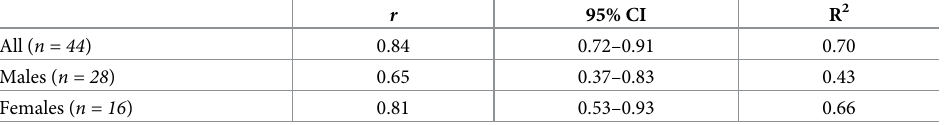
Table 2. Correlation and coefficient of determination for the association between the IsoKai Peak (kg) and the esti- mated 1RM (1RM